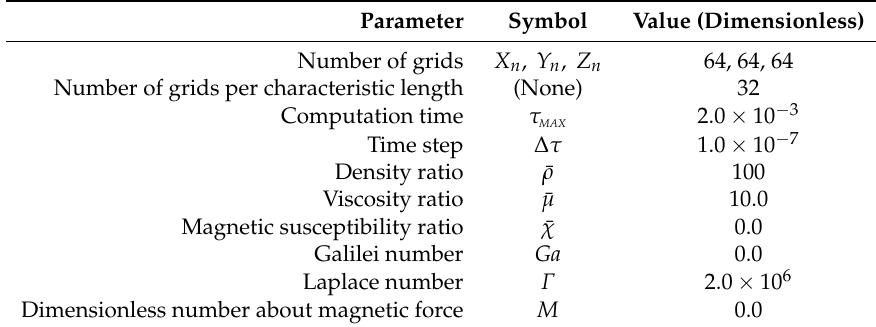
Table 4. Dimensionless computational conditions for droplet